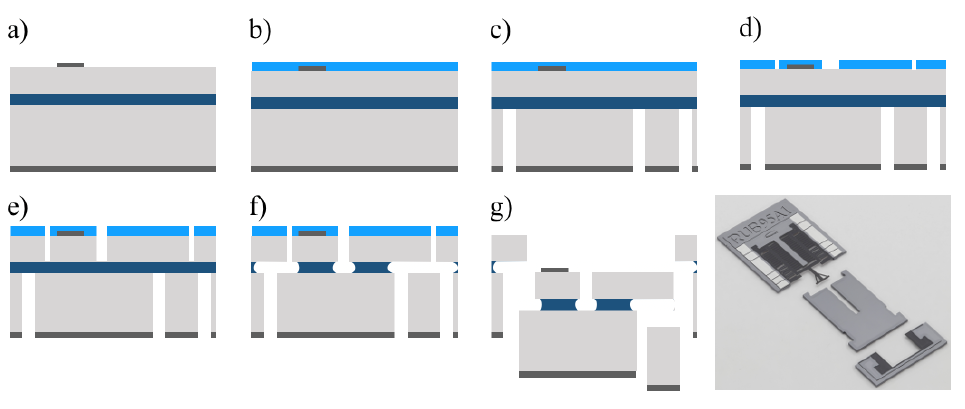
Figure 5. Main fabrication steps of the constant-force chip with free moveable measurement tip: ( a ) aluminium electrodes ( b ) SiO 2 hard mask ( c ) DRIE handle layer ( d ) patterning of the SiO 2 hard mask ( e ) DRIE device layer ( f ) HF-vapor etching ( g ) dicing